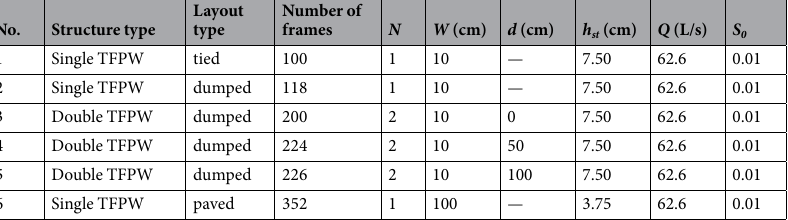
Table 1. Summary of TFPW dimensions and experimental data for each test. Note: N = number of weirs; W = width of a single structure; d = distance between the Double TFPW; h st = height of the TFPW; Q = flow discharge; S 0 = slope of flume. TFPW layouts are shown in Fig.